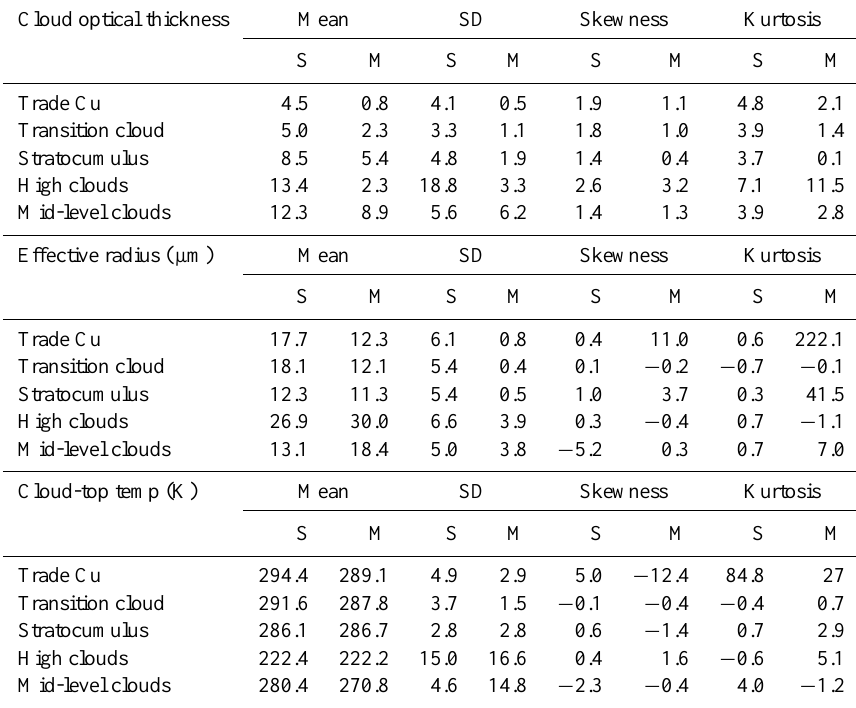
Table 1. Mean, standard deviation, skewness and kurtosis of MODIS-derived (“S” for satellite columns) and ERA-Interim-derived (“M” for model columns) cloud parameters ( τ c , r e , T c